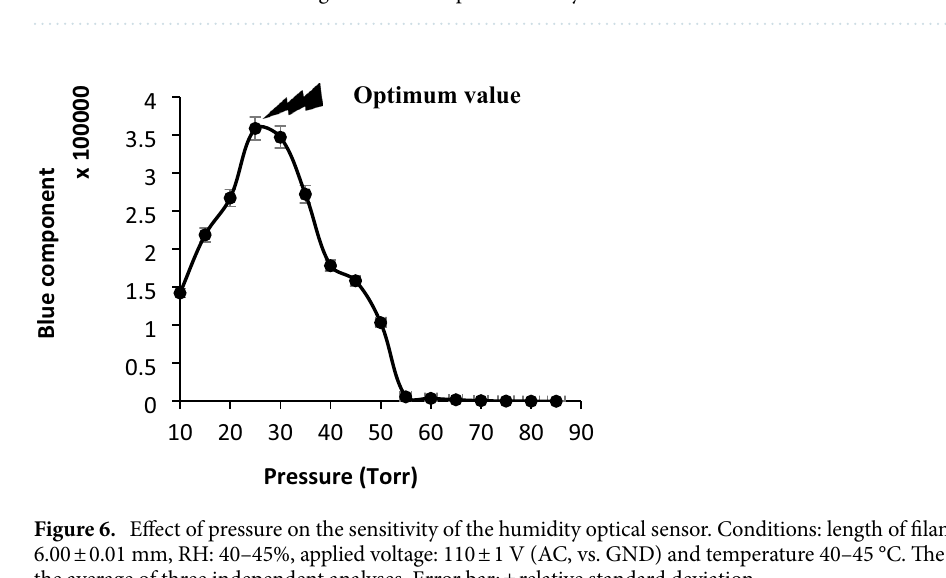
Figure 5. Correlation between the blue components and different applied potential. The data are the average of three independent analyses. Conditions: length of filament 6.00 ± 0.01 mm, RH: 40–45%, and temperature 40–45 °C. The data are the average of three independent analyses. Error bar: ± relative standard deviation.